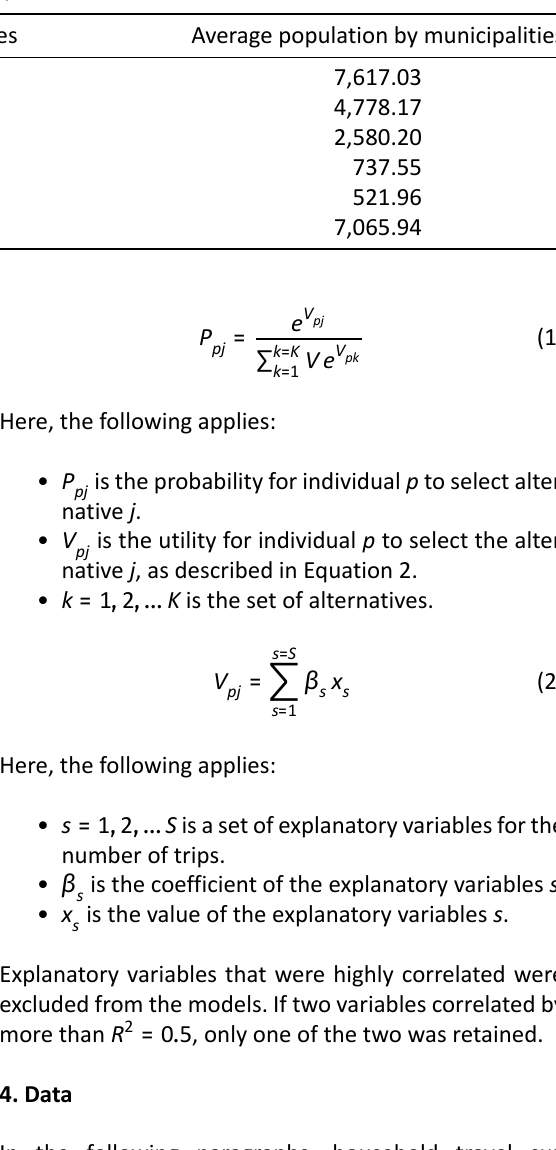
Table 1. Average absolute error of controlled attributes by